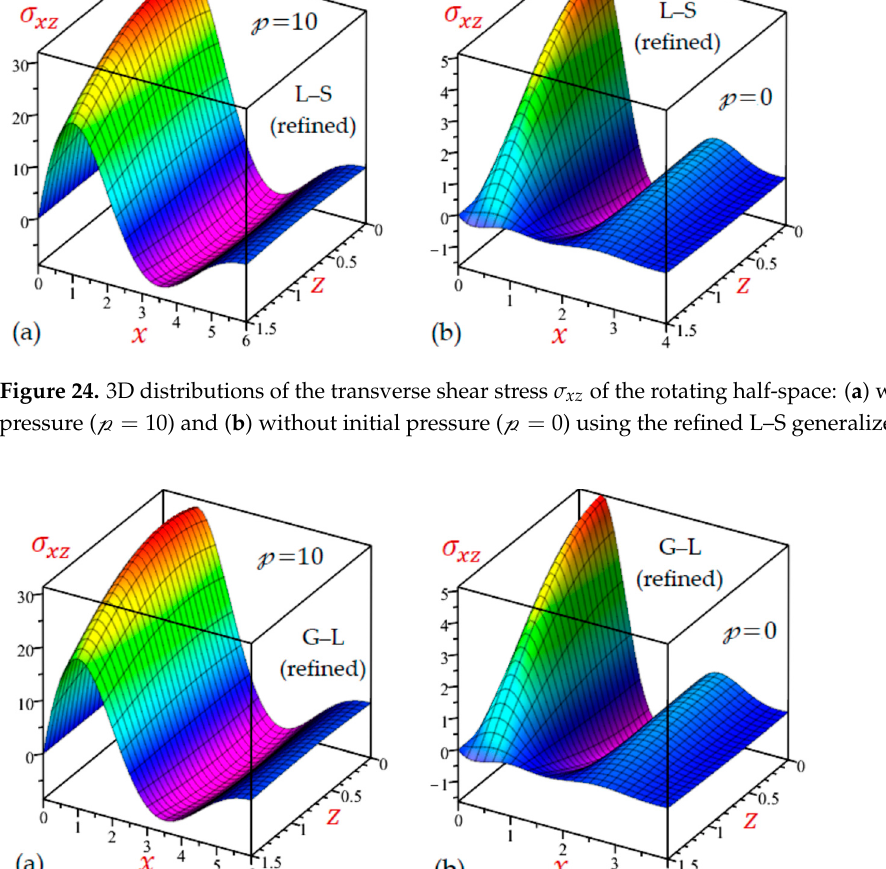
Figure 25. 3D distributions of the transverse shear stress 𝜎 (cid:3051)(cid:3053) of the rotating half-space: ( a ) with